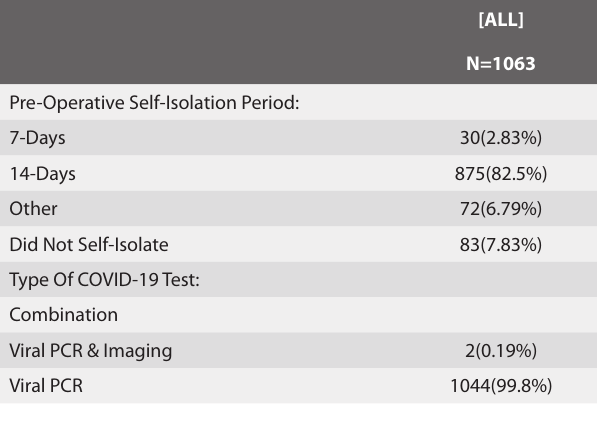
Table 3. COVID status and pre-operative